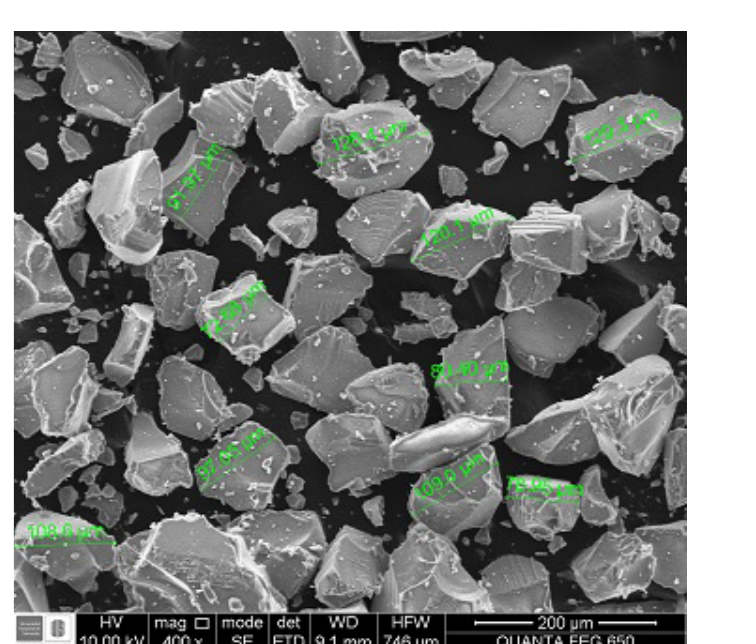
Figure 5. SEM Image of synthesized SiO particles at 200 µm 2 assigned, respectively to, Si(OSi) [Q 4 ], (HO)Si(OSi) [Q 3 ], integrated intensities of organosiloxane (T m ) and siloxane 4 3 (HO) Si(OSi) [Q 2 ], RSi(OSi) [T 3 ] and RSi(OSi) (OH) [T 2 ] (Q n ) signals calculated in the form of T m /(T m +Q n ) allowed 2 2 3 2 environments about silicon. The appearance of T m signals the quantitative assessment of the incorporation degree (RSi(OSi)m(OH) -m being R the structure of the IL and of the ionic liquid moieties. The measured ionic liquid 3 taking m values of 3 and 2 to form the structures) evidences moieties content was 0.21 mmol/mol of SiO the existence of Si-C in the framework and thus the effective close to that expected on the basis of the initial mixture incorporation of the ionic liquid moieties. The relative (0.80 mol/mol of SiO ). 2